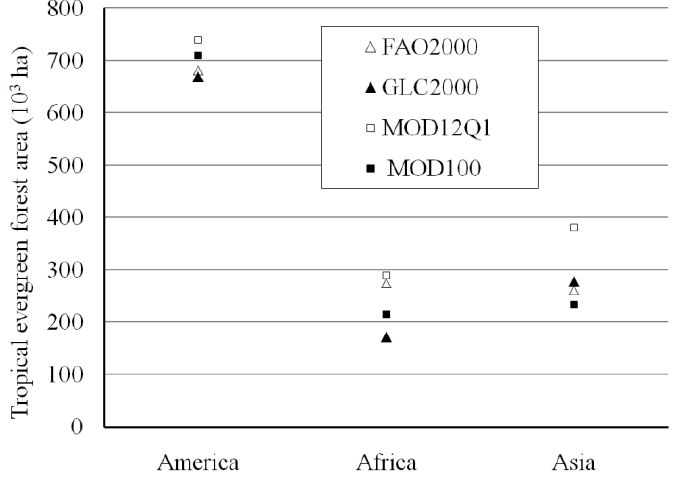
Figure 2. A comparison of evergreen forest areas in the tropical America, Africa and Asia (30 ° N–30 ° S) among the four global forest datasets (MOD100, MOD12Q1, GLC2000 and FAO FRA